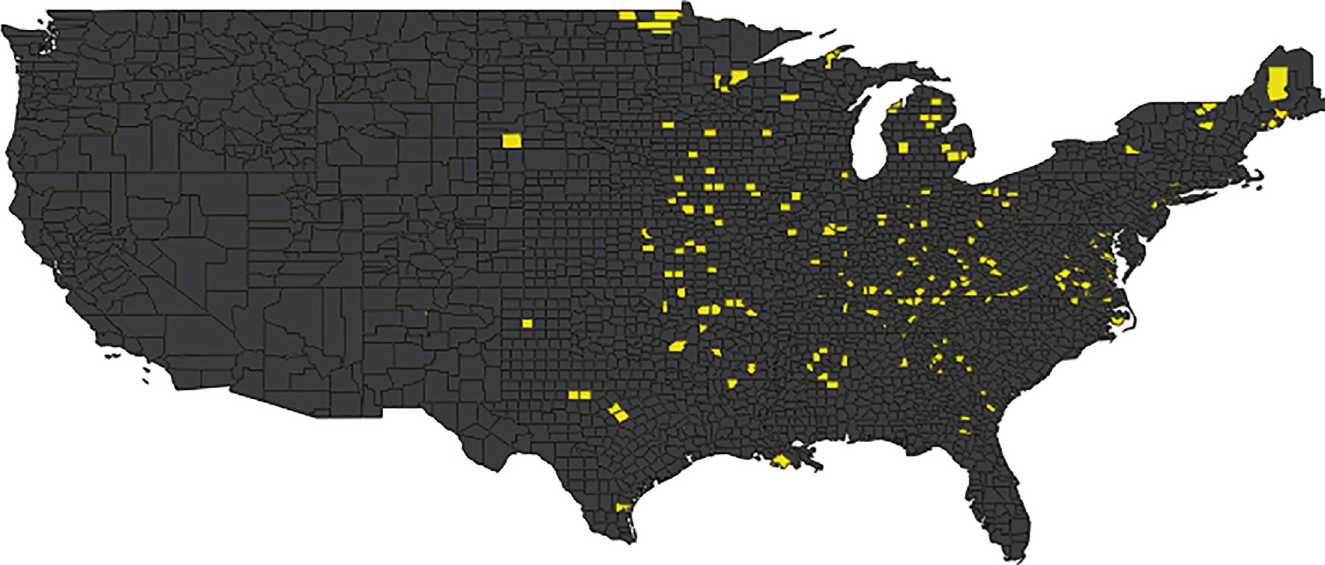
Fig 2. Counties with potential water stress relief from promoted domestic actions. Only 174 (6%) of all counties have the potential to be relieved from water stress (yellow) by full adoption of conventionally supported household water conservation actions.